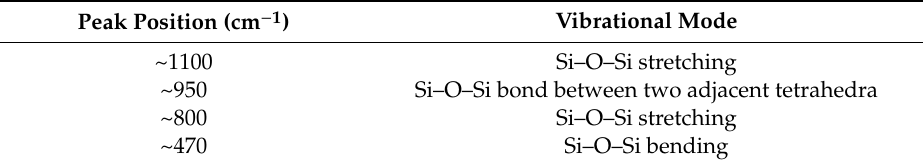
Figure 4. FT-IR spectra of SiO 2 / HA_p and SiO 2 / HA_c hybrid NPs. Table 1. Meaningful FT-IR bands of SiO 2 / HA hybrid NPs.